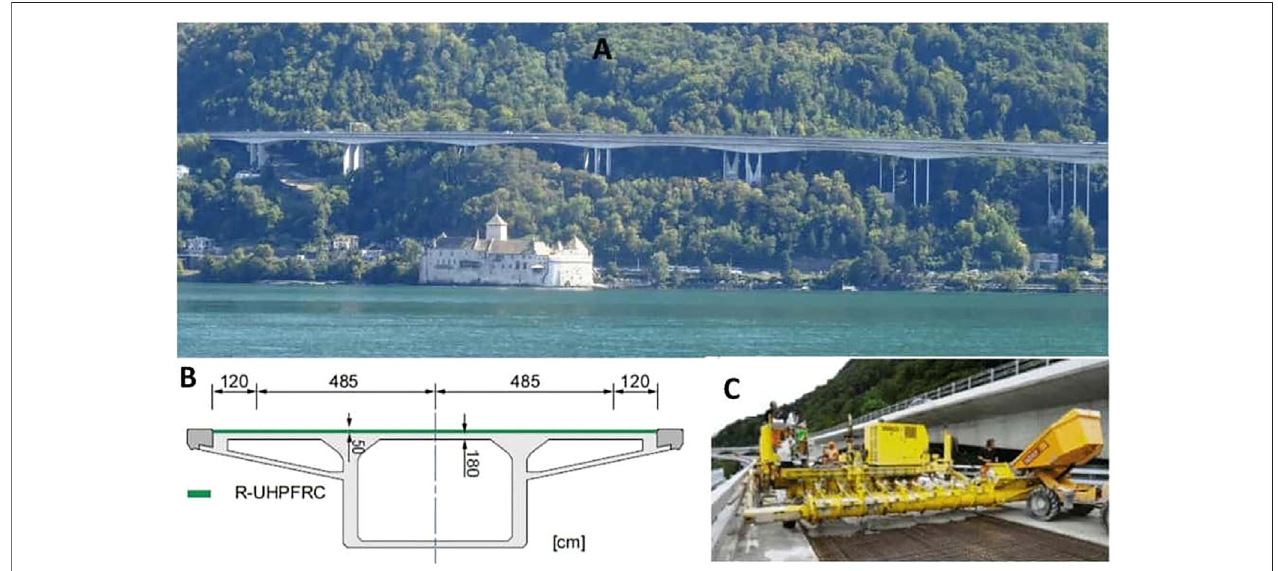
FIGURE9| ChillonViaduct. (A) OverviewoftheviaductabovetheLemanLakeandChillonCastle; (B) cross-sectionofthebridgeandtheintervention; (C) UHPFRC casting (Photographs: E. Brühwiler).